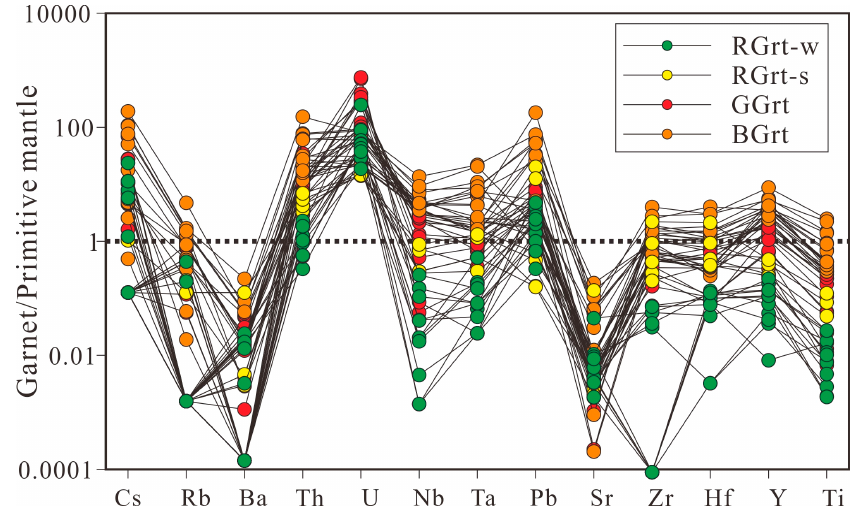
Figure 10. Trace element spider diagram of garnets from Yongping. Samples were normalized to the primitive mantle values [65].